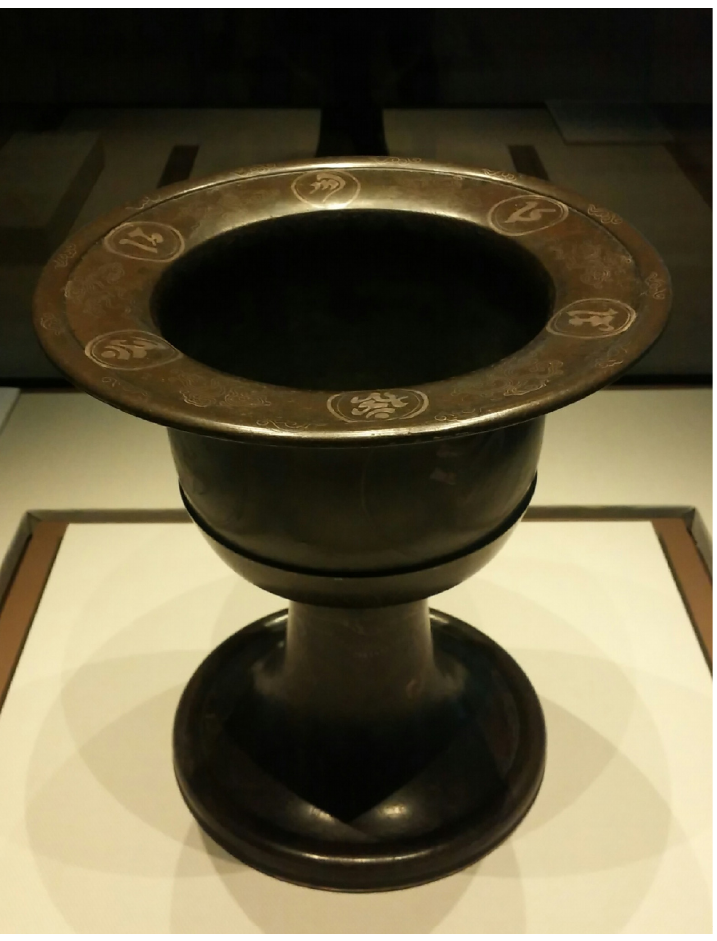
Figure 16. Incense burner. Kory ŏ dynasty, dated 1177. H. 27.5 cm. P’yoch’ungsa, Miryang, South Ky ŏ ngnam Province of Korea.